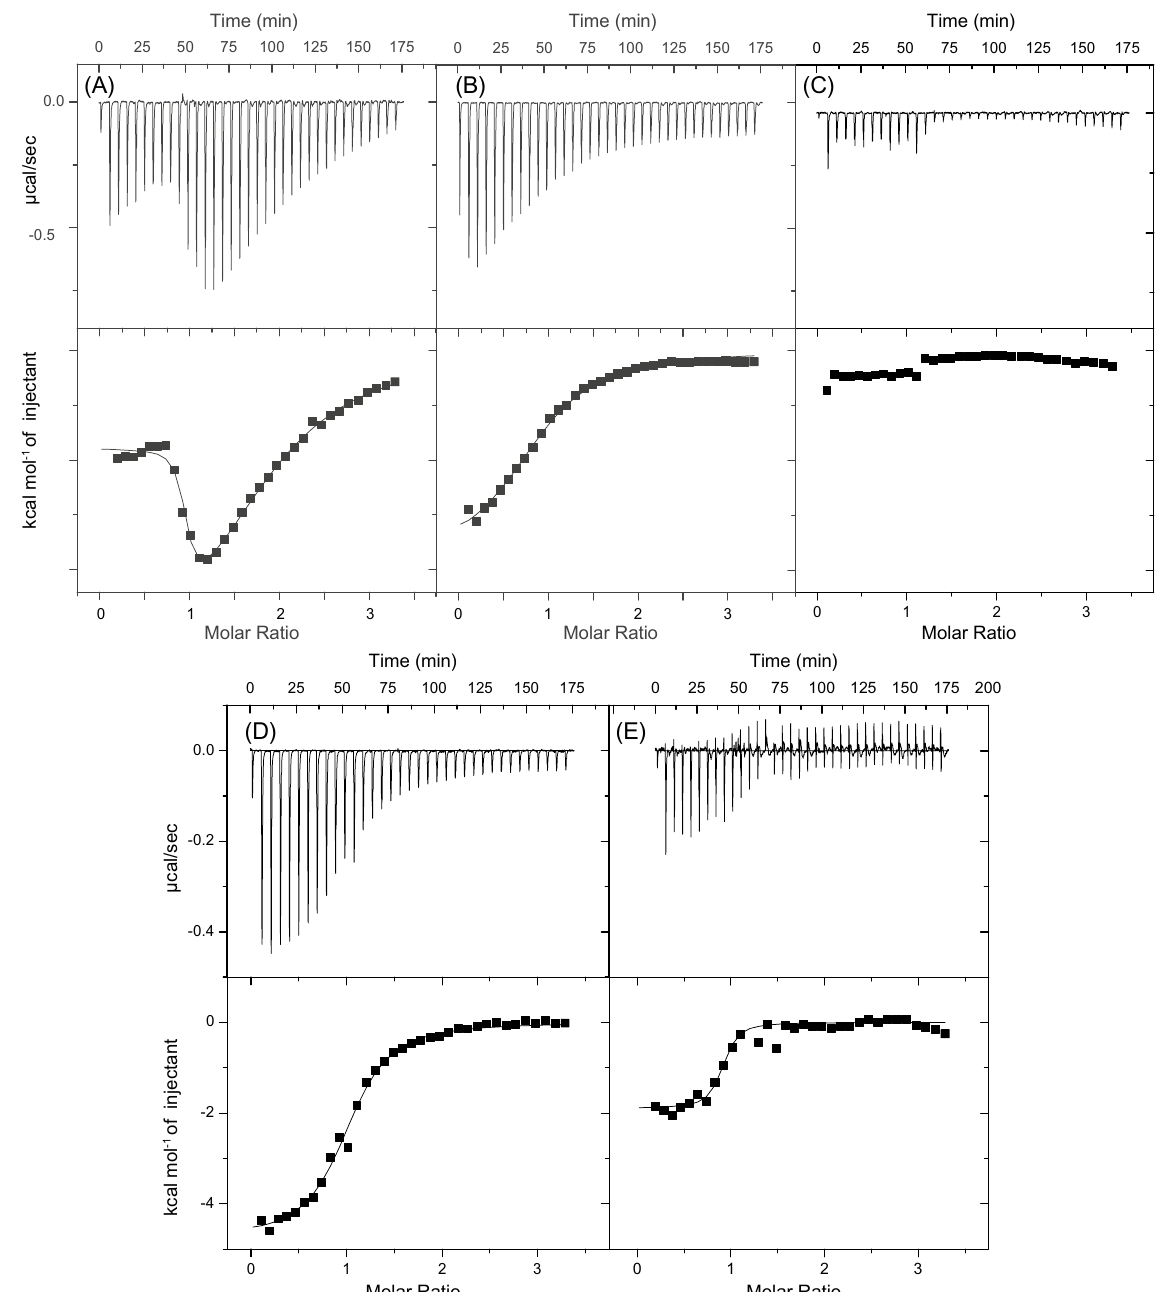
Figure 2. ITC thermograms showing interaction of ART with the MN4 aptamer in buffer containing 20 mM TRIS (pH 7.4), 5 mM KCl, 2.4% (v/v) DMSO, in ( A ) 140 mM NaCl and ( B ) 0 mM NaCl. ( C ) Interaction of 2-deoxyartemisinin with the MN4 aptamer in 20 mM TRIS (pH 7.4), 140 mM NaCl, 5 mM KCl, 1.5% (v/v) DMSO. ( D ) Quinine titrated into the MN4·ART complex. ( E ) ART titrated into the MN4·quinine complex. Unless otherwise specified, ITC competition experiments were acquired in buffer containing 20 mM TRIS (pH 7.4), 140 mM NaCl, 5 mM KCl, 1% DMSO. All ITC data were acquired at 15